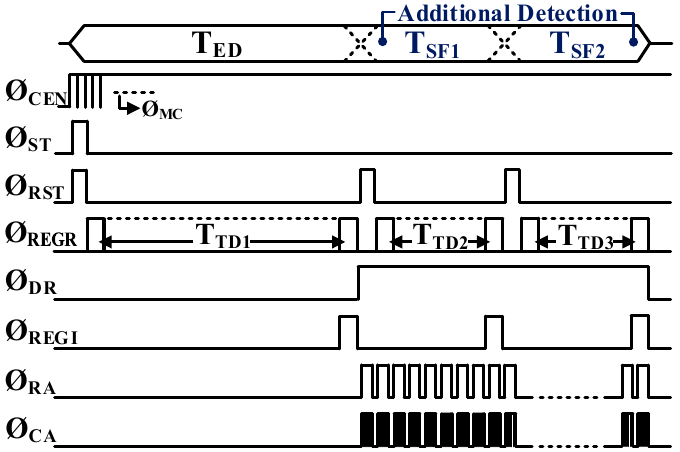
Figure 5. Operational timing diagram of the prototype FPA-based LADAR.